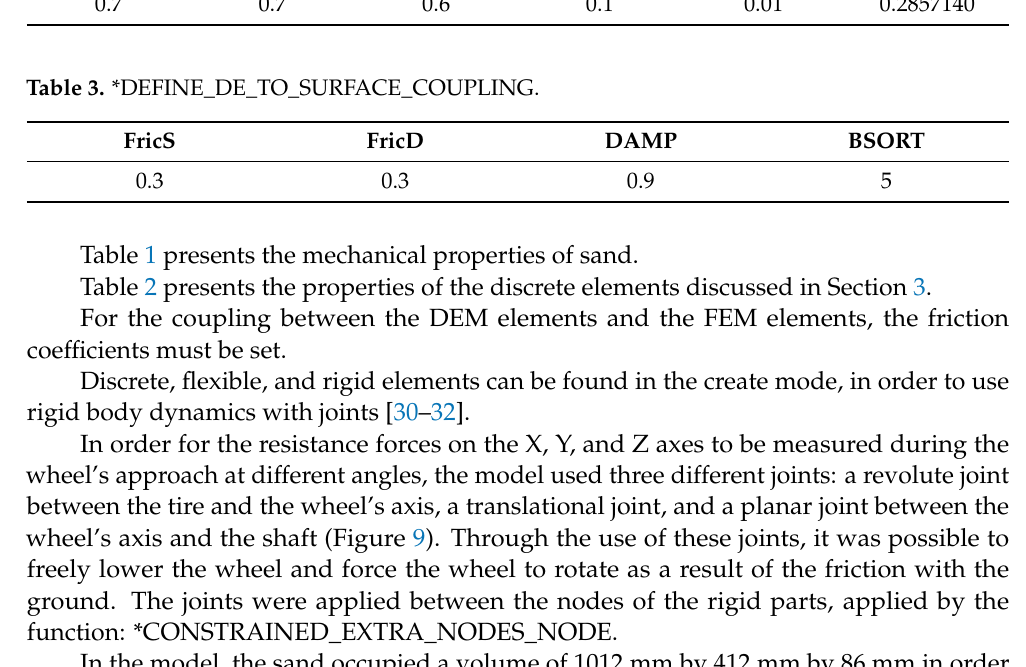
Figure 11. The numerical model with marked joints between the wheel and the shaft. 5. Results Simulations were carried out for four different wheel slip angle variants, being straight ahead, 30°, 60°, and 90°, where the Fy force stabilized in 0.3 s on the revolute joint with a force of 600 N. This resulted from the weight of the wheel together with the weight of the system (total weight 61.19 kg). In the first phase of the simulation, the drop test was applied to the tire with the system to determine the sinkage level. One of the methods for presenting the results were displacement counters of the discrete elements in the Y direction [3]. This could be used to determine if there was enough width for the tire to move (Figure 12). ( a ) ( b )